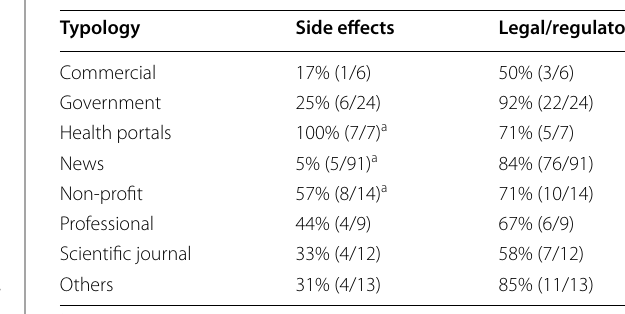
Table 1 Mention of side effects and legal/regulatory aspects across different website